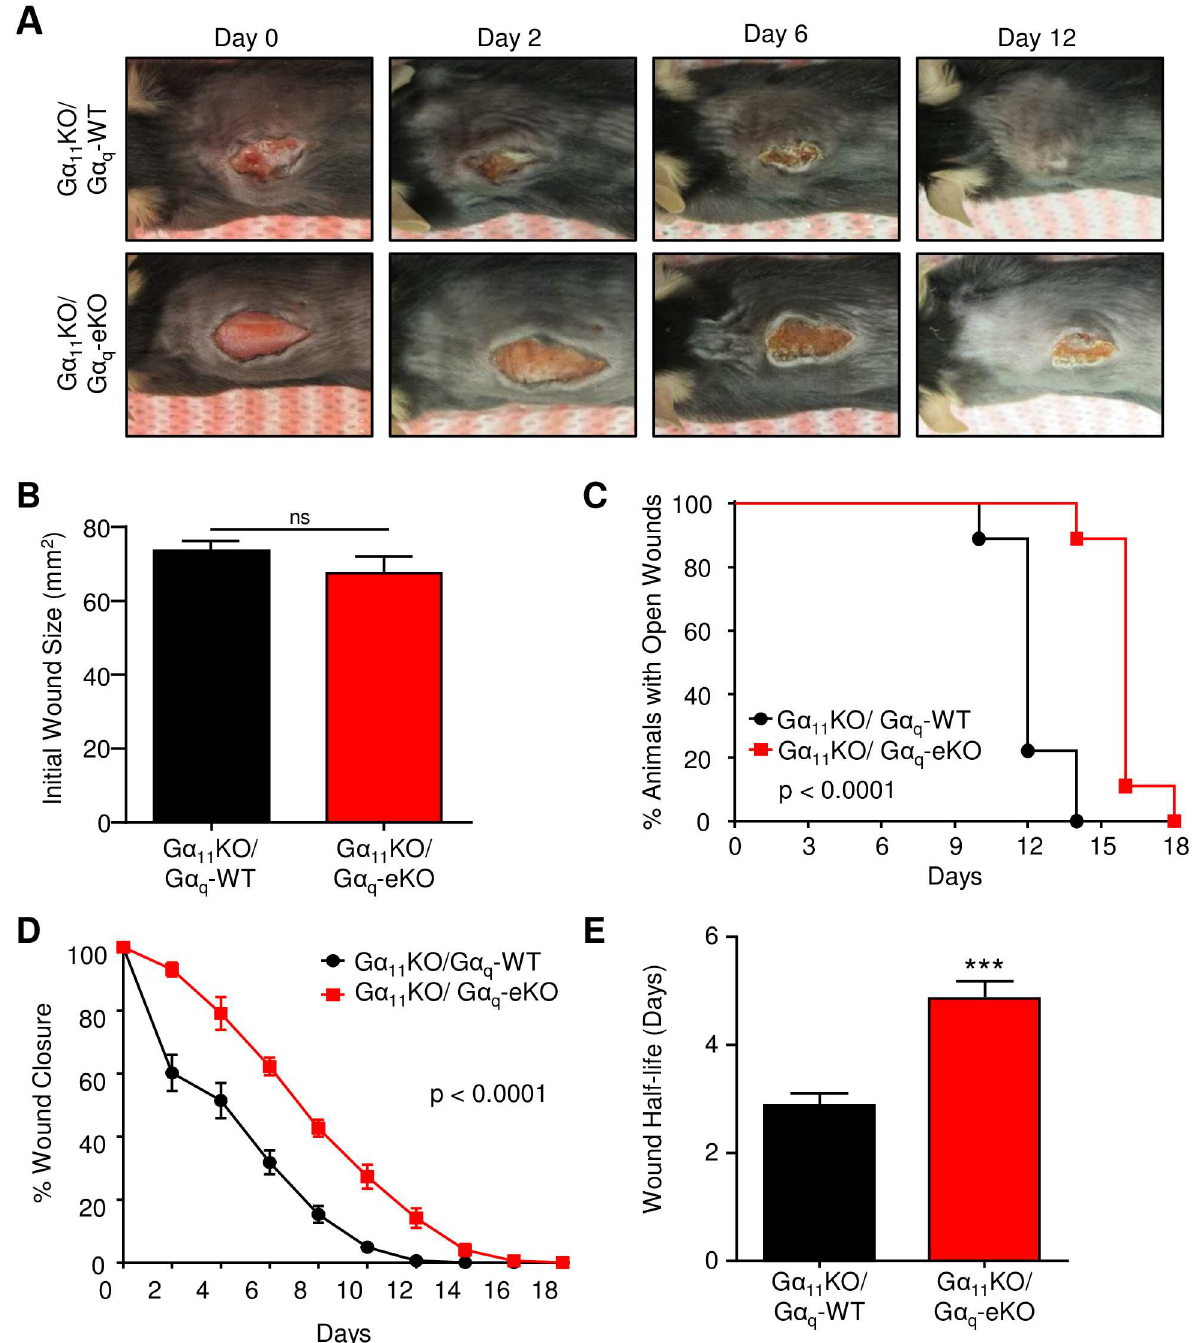
Fig 4. G α 11 KO/G α q -eKO mice have delayed wound healing. G α 11 KO/G α q -WT control and G α 11 KO/G α q -eKO mice received 15 mm incisionalwoundand closure was monitored over 18 days. A) Gross examination of the woundsin G α 11 KO/G α q -WT control (N = 15) and G α 11 KO/G α q -eKO (N = 10) mice. B) Initial woundsize. Statistical significancedetermined by Student’st-test. C) Kaplan-Meier survival curve of woundclosure. Statistical significance was determinedby log-ranktest. D) Wound closureover time. Statistical significancewas determined by two-way ANOVA. E) Wound half-life for G α 11 KO/G α q -WT control and G α 11 KO/G α q -eKO animals, as determinedfrom the rate of woundclosureover time. Statistical significancewas determinedby Student’st-test, *** p < 0.001.